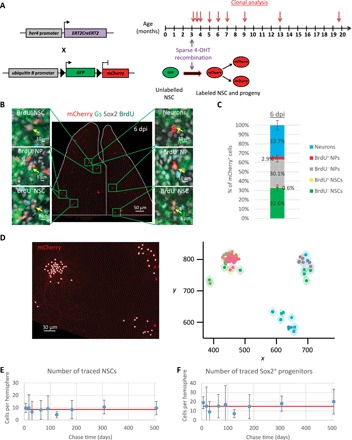
Lineage tracing of her4.1-expressing NSCs shows homeostasis.(A) Cre recombination was sparsely induced in 3-mpf her4.1:ERT2CreERT2;ubi:Switch double transgenic adults by 4-OHT, resulting in mCherry expression in recombined NSCs and their progeny. Analyzed time points (arrows) span between 6 and 507 dpi. (B) Dorsal view of a representative pallium showing sparsely induced cells at 6 dpi (dotted area to the pallial Dm territory of interest; fig. S1E). Boxed areas are magnified to illustrate the different cell types traced (yellow arrows). Proliferating progenitors were labeled by a 24-hour 5-bromo-2′-deoxyuridine (BrdU) pulse. NSCs are Gs+ and Sox2+, NPs are Sox2+ only. In contrast to aNSCs and aNPs, qNSCs and qNPs did not incorporate BrdU during the pulse. (C) Cell type composition of the mCherry+ population at 6 dpi. n = 6 brains. (D) Example of clustering at 183 dpi. Left: Dorsal view of a 3D reconstruction of a hemisphere. The spots registering the coordinates of traced cells (red) are shown (white dots). Right: 2D map of the highest probability clonal partition identified by the statistical inference. Axes correspond to the x and y coordinates (in μm) of the 2D projection of the cell centers. Cells belonging to the same clone are embedded in the same shaded area. (E) Average number of traced (mCherry+) Gs+/Sox2+ NSCs per hemisphere across all time points analyzed. One-way analysis of variance (ANOVA): F(8,37) = 1, P = 0.45; all pairwise comparisons: least significant difference (LSD) test followed by Holm’s adjustment. Error bars, 95% confidence interval (CI). (F) Average number of traced (mCherry+) Sox2+ cells per hemisphere across all time points analyzed. One-way ANOVA: F(8,37) = 1.65, P = 0.14; all pairwise comparisons: LSD test followed by Holm’s adjustment. Error bars, 95% CI. (E and F) n = 6, 3, 3, 3, 4, 6, 7, 8, and 6 brains at 6, 18, 30, 64, 91, 125, 183, 307, and 507 dpi, respectively.